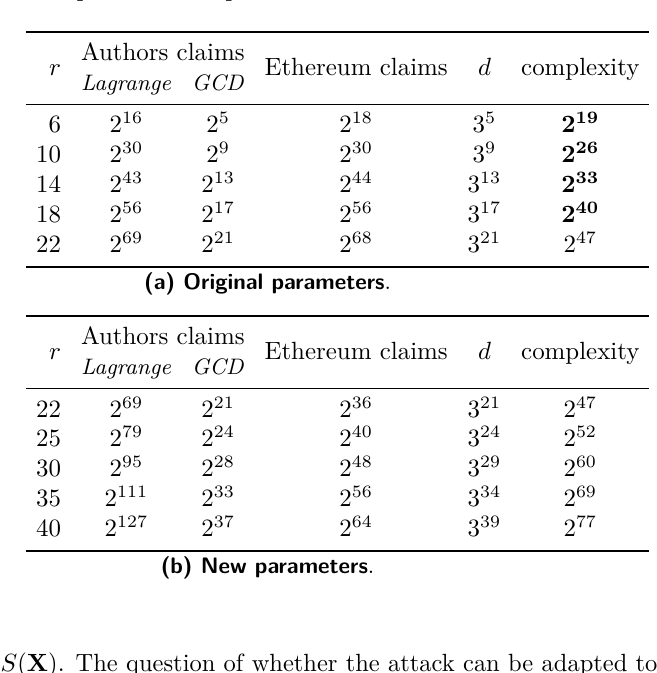
Table 1: Complexity of our attack against Feistel–MiMC, compared with the security claims given by the authors and by the challenges. Complexity figures in bold correspond to attacks that we have implemented in